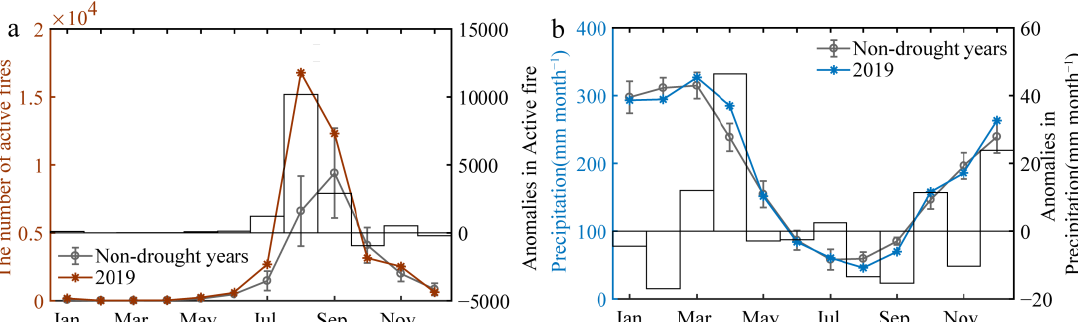
Figure 2. A comparison of monthly averaged ( a ) active fires and ( b ) precipitation between 2019 and non-drought years. Colored lines with asterisks show the averages of each month in 2019, whereas gray lines with circles show the averages of each month in the non-drought years with standard deviations indicated by an error bar. The anomalies of each month in 2019 are shown as bar charts with a black line.